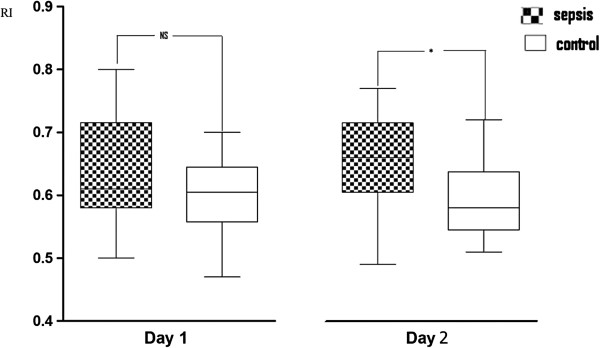
Resistance Index (RI) on the 2 days.